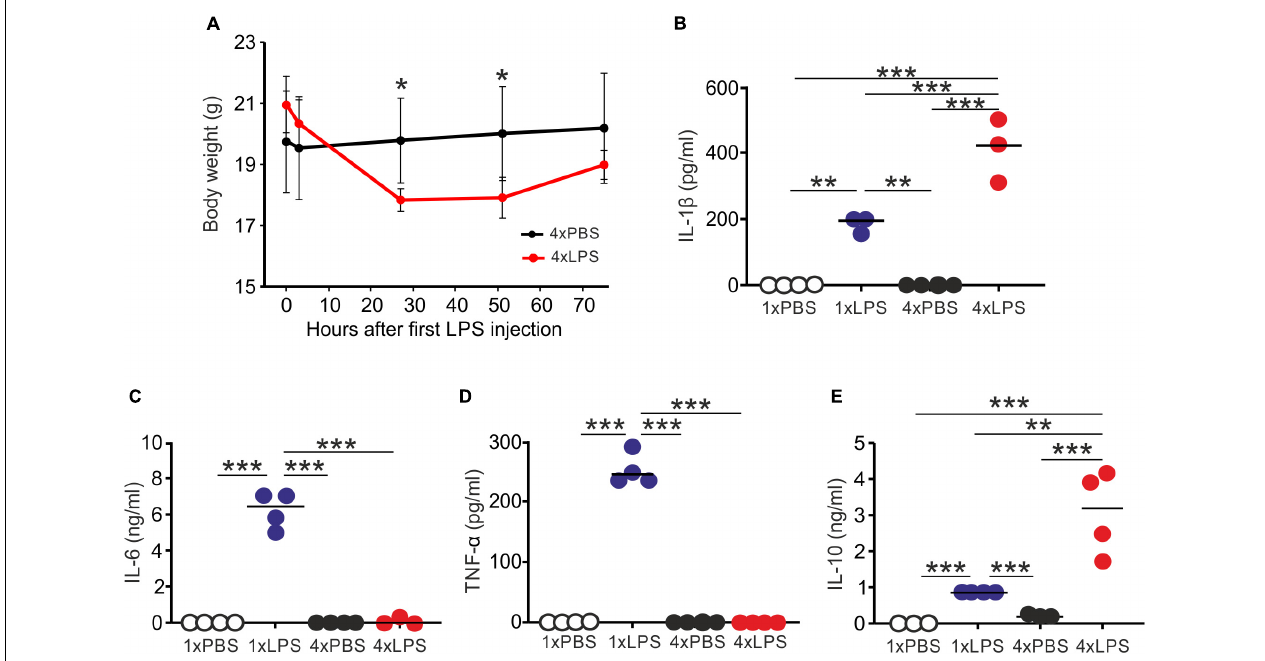
FIGURE 1 | Multiple LPS exposure induces innate immune tolerance. (A) Groups of mice ( n = 4/group) were given four daily IP injections with either LPS or PBS (control) and body weight measured at intervals afterward. (B,C) Mice were given a single (1x) or four (4x) daily IP injections with either LPS or PBS (control) and serum collected 3 h after the final injection. (B) Concentration of IL-1 β in the serum of mice given a single or four daily IP injections with either LPS or PBS. (C) Concentration of IL-6 in the serum of mice given a single or four daily IP injections with either LPS or PBS. (D) Concentration of TNF- α in the serum of mice given a single or four daily IP injections with either LPS or PBS. (E) Concentration of IL-10 in the serum of mice given a single or four daily IP injections with either LPS or PBS. N = 3–4 mice/group; horizontal bar, median. * P < 0.05; ** P < 0.01; *** P < 0.001.